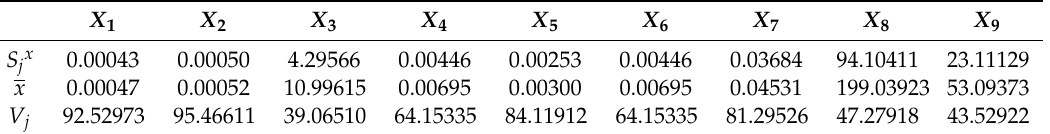
Table 2. Results of the calculation of the coe ffi cient of variation for potential diagnostic features for a 2010 year (own study).